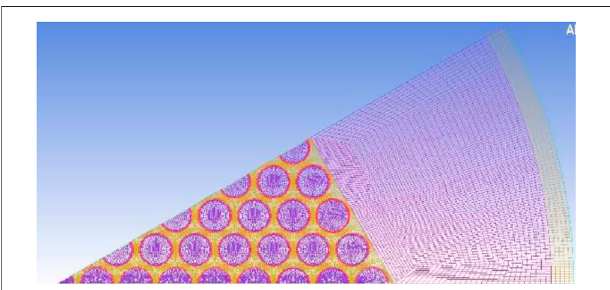
FIGURE 11 | Schematic diagram of the detailed mesh.